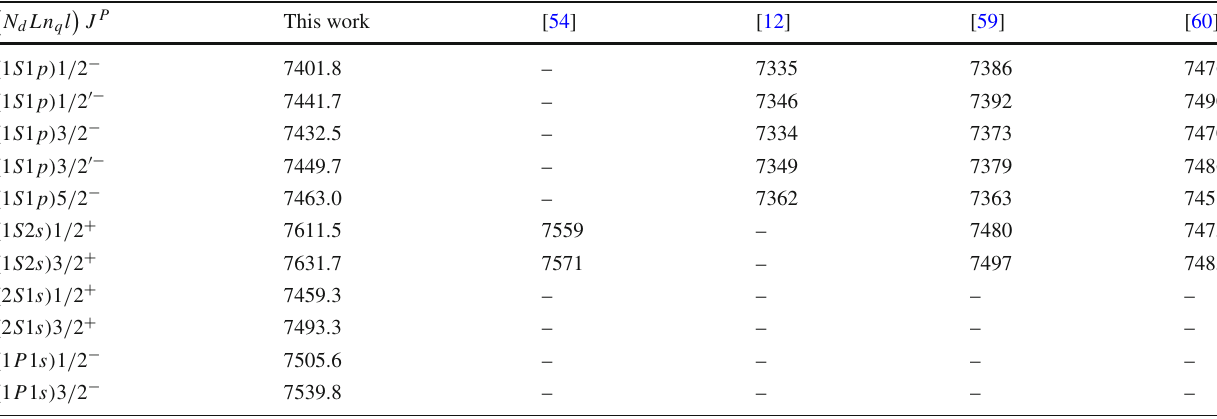
Table 15 Mass spectra of (cid:3) bc baryons (in MeV). Our results are obtained by the respective sum of the mean mass of the (cid:3) bc in Table 3, the binding energy shift(vanishes in 1S1s wave) in Table 9 and its splittings in Sect. 3 with the couplings given in Sect. 4 (cid:9) (cid:10) N d Ln q l J